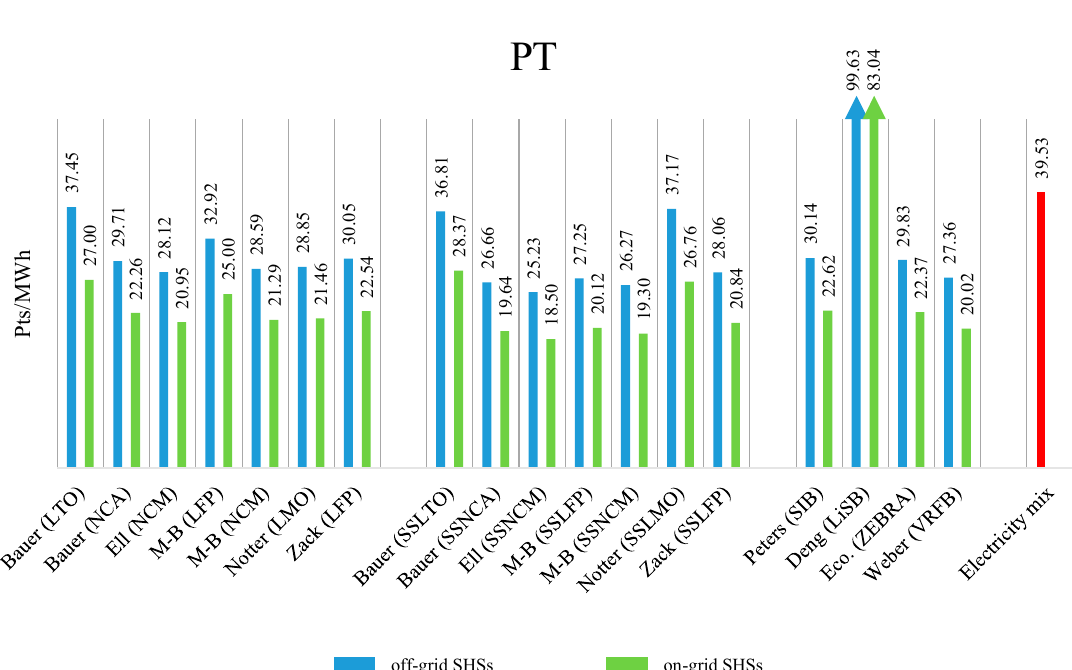
Figure 10. LCA impact values of SHSs in Italy as single scores. Energies 2020 , 13 , x FOR PEER REVIEW